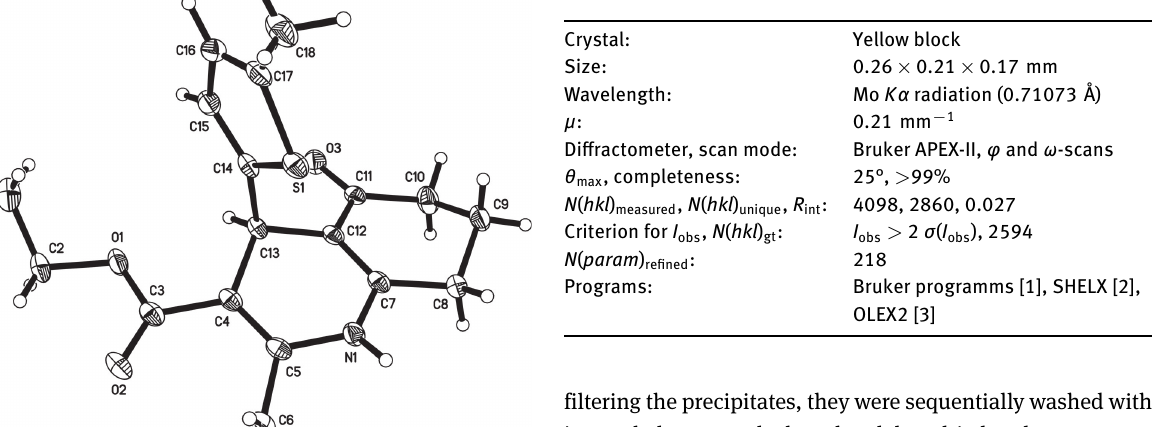
Table 1: Data collection and